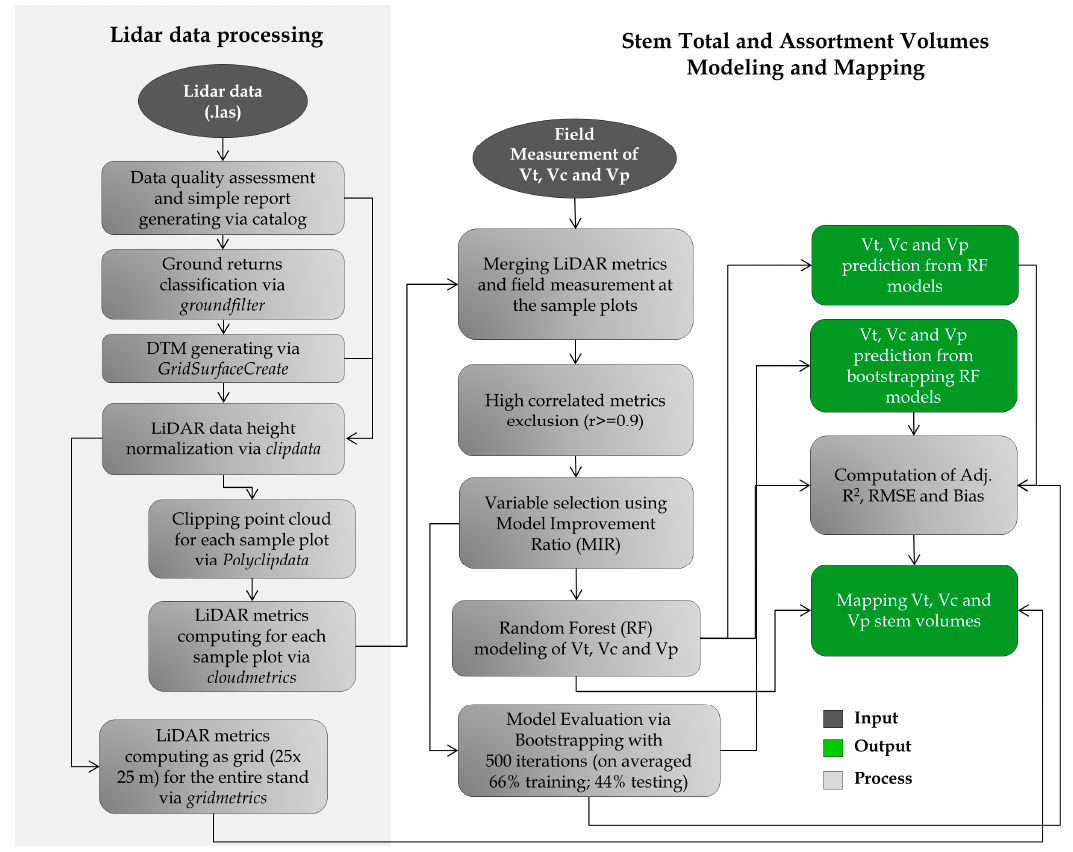
Figure 3. Procedure for predicting stem total and assortment volumes in an industrial P. taeda forest plantation using airborne laser scanning data and random forest.